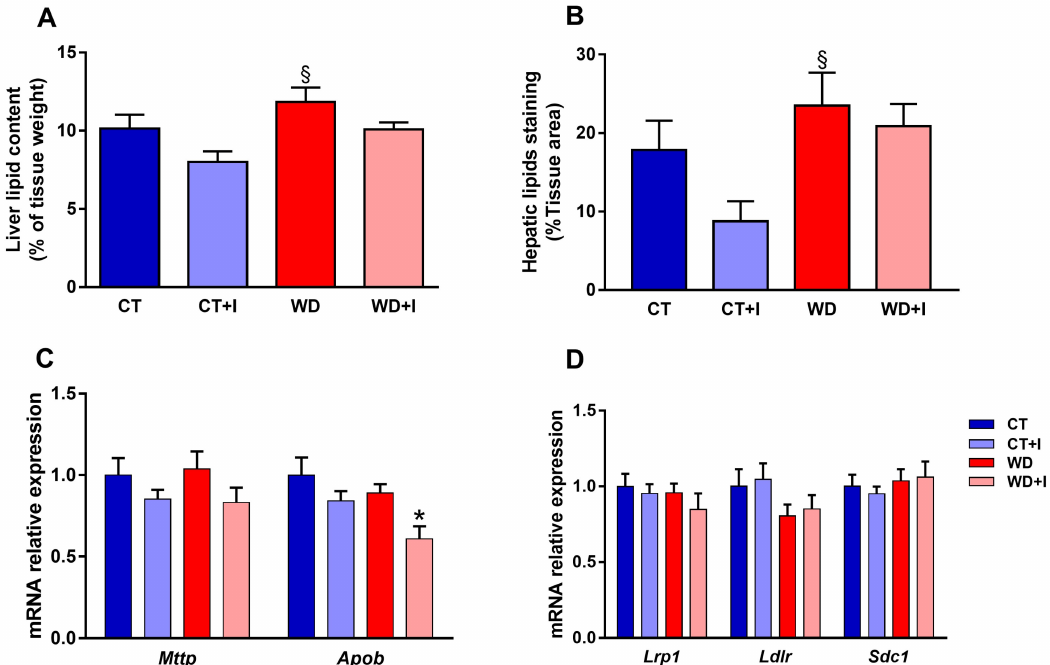
Figure 6. Liver lipid content ( A ). Quantification of hepatic lipid staining with oil red O ( B ). Level of mRNA expression of Mttp and Apob , involved in VLDL synthesis in the liver ( C ). Level of mRNA expression of remnant receptors Lrp1 , Ldlr and Sdc1 in the liver ( D ). Data are presented as mean ± SEM and analyzed with two-way ANOVA followed by Tukey post hoc tests. * p < 0.05 versus CT, § p < 0.05 versus CT +